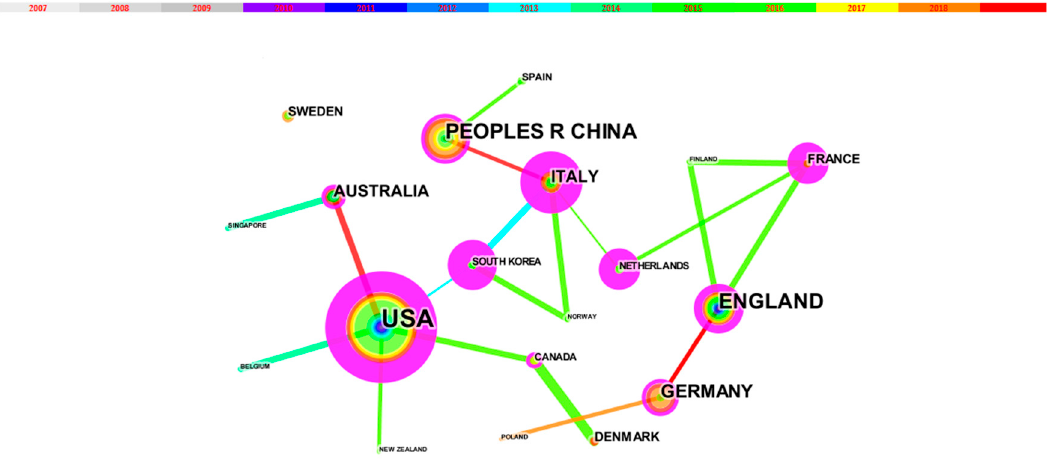
Figure 3. National cooperation network.